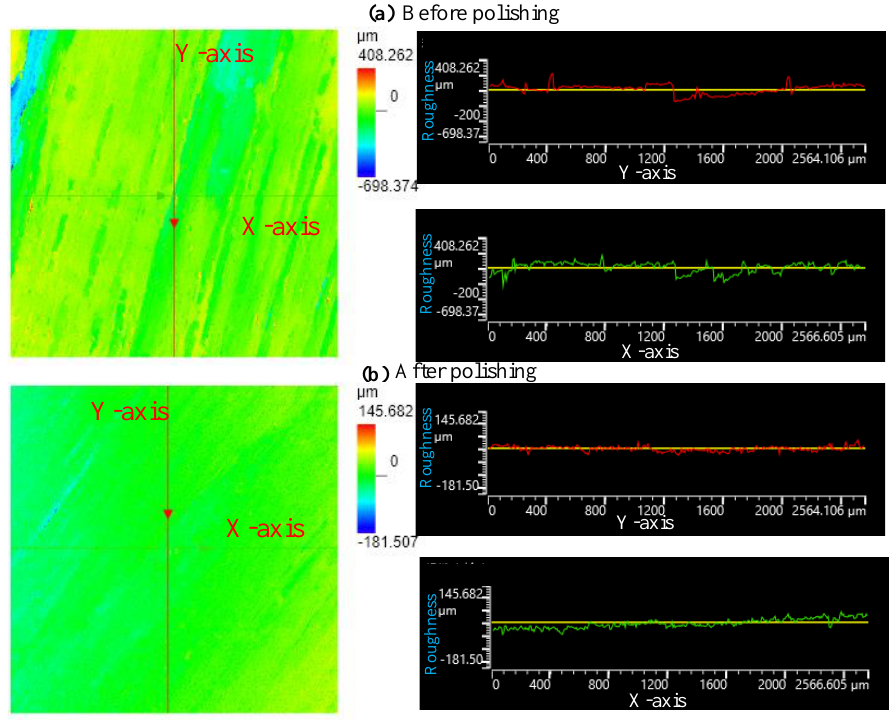
Figure 13. Surface microstructure on P04-path1 in 2D ( a ) before polishing, ( b ) after